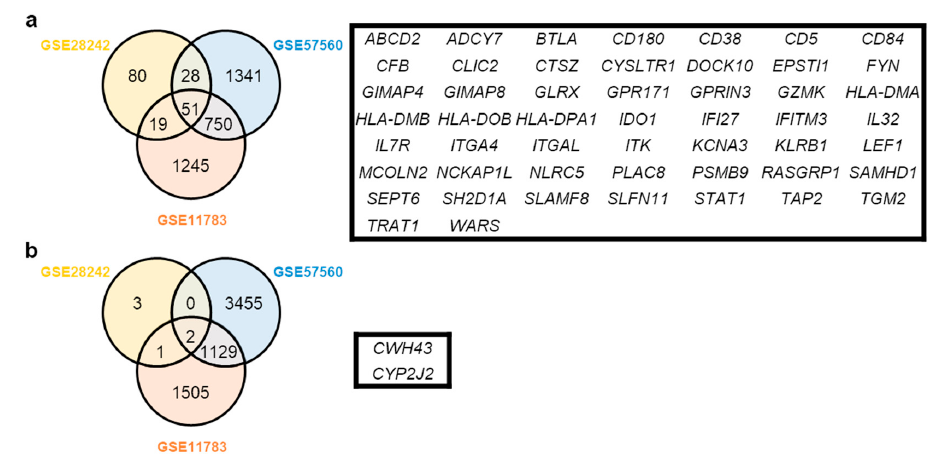
Figure 2. Analysis of common positive and negative genes in IC/BPS. The intersections are common significantly expressed genes from 3 datasets of the Gene Expression Omnibus (GEO) database. There are positive gene groups ( a ) and negative groups ( b ).